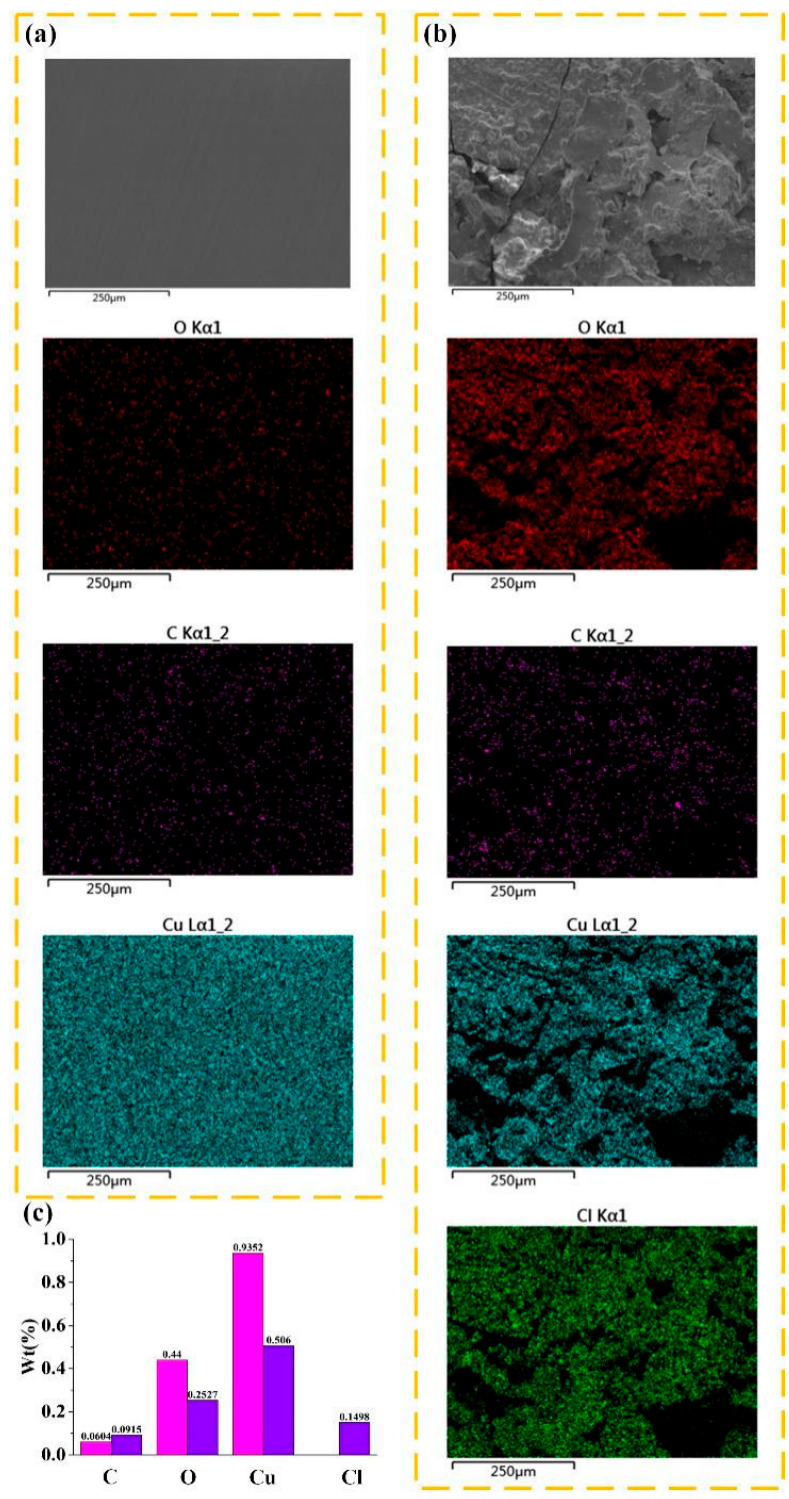
Figure 8. Elemental analysis of ( a ) the surface of the copper foil and ( b ) the copper foil surface treated with sodium chloride solution. ( c ) Comparison of element proportion on the copper foil surface treated with sodium chloride solution.